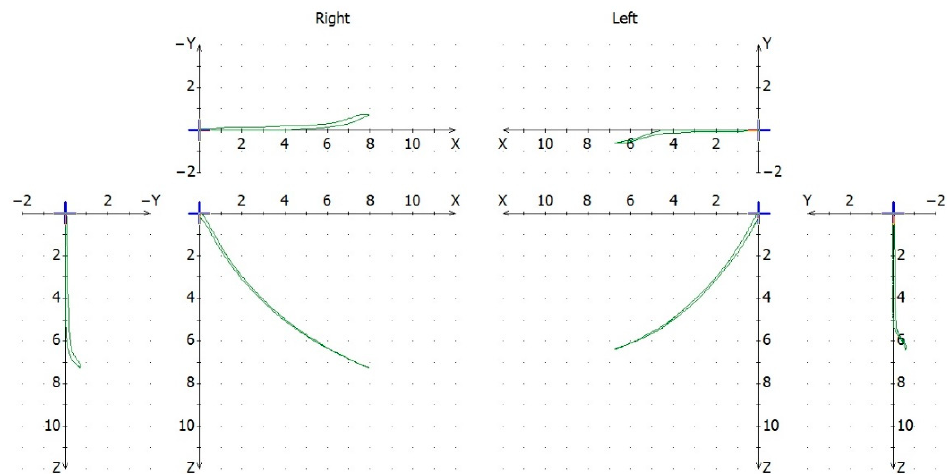
Figure 3. Registration in Cadiax Compact during the protrusion movement.